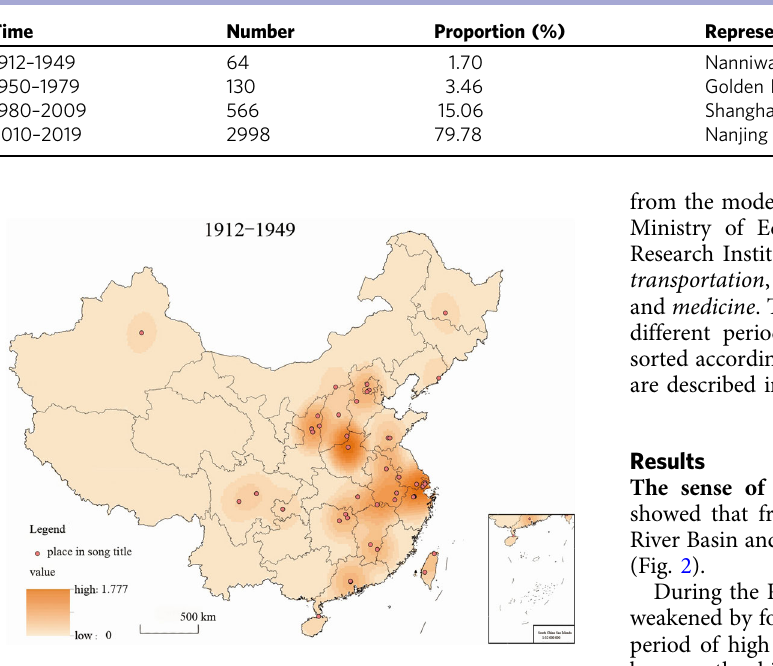
Fig. 2 Kernel density estimation of place in music in 1912 – 1949. Kernel density estimation of place in music titles from 1912 to 1949 indicates that the darker areas are distributed primarily in the Yellow River Basin and the Yangtze River Delta region. These places are often referred to in song titles, forming a